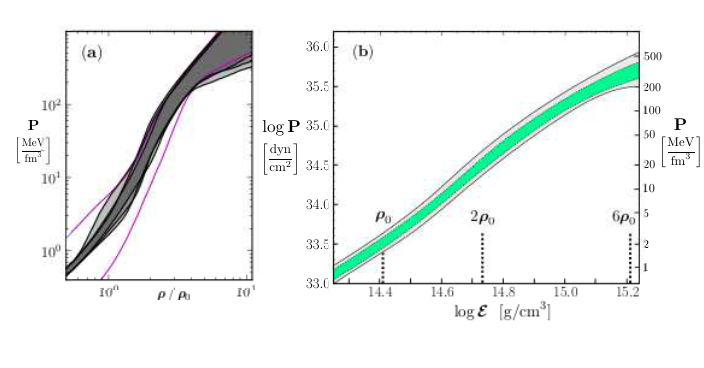
Figure 1. Two recent examples of deduced EoS of neutron using Bayes inference methods with data sets described in Section 2.1 as input: (a) pressure of baryon density ρ (in units of ρ 0 = 0 . 16 fm − 3 ) [14] and (b) as function of the